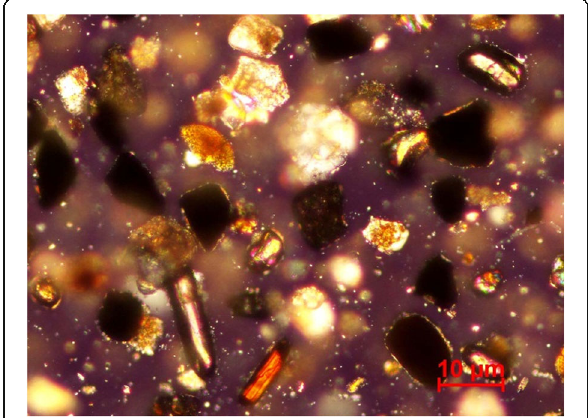
Fig. 12 Heavy fraction composed of opaque ’ s (isotropic), zircon (exhibits zoning and green, yellow, or violet interference colors), staurolite (exhibits golden yellow interference colors at the lower part), and epidote (exhibits yellow interference colors at the upper left corner), heavy fraction, C.N. × 100